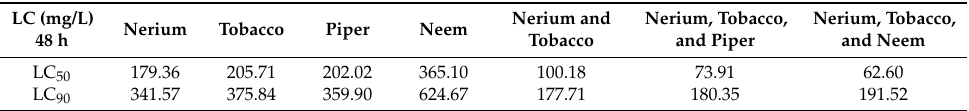
Table 7. Comparison of LC 90 values of individual, binary, and tri-herbal extracts for their synergistic molluscicidal effects on P.